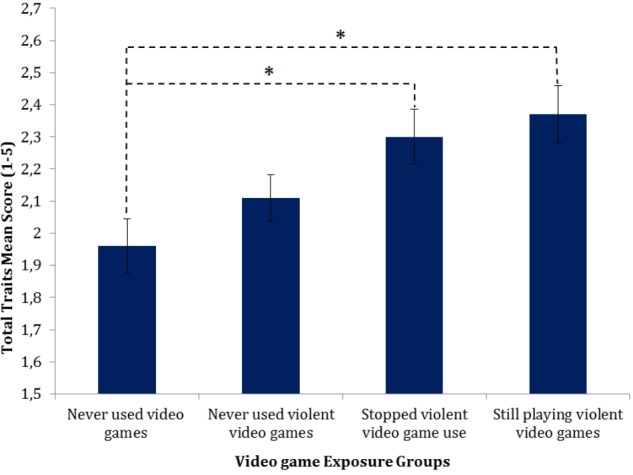
Normalized means plot of overall trait expression across video game groups. Error bars denote standard errors (SEs). ∗Sidak corrected p-value < 0.05.